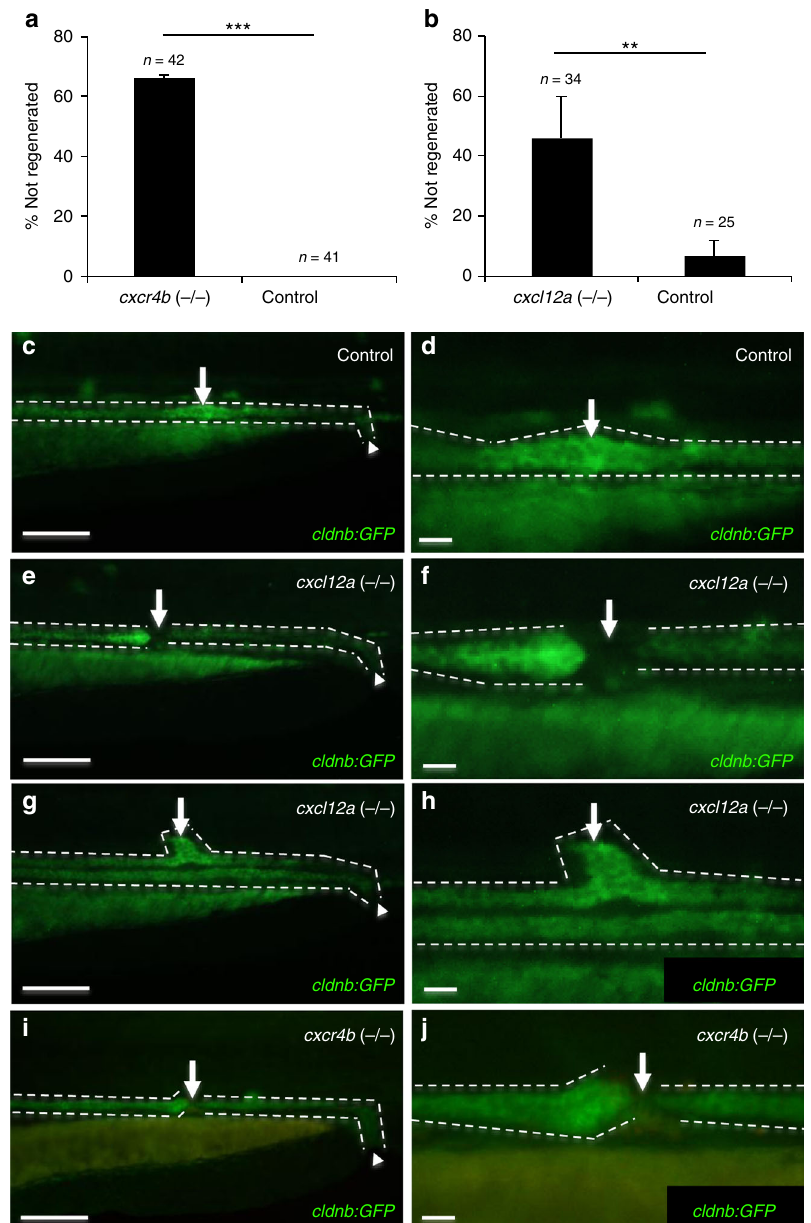
Fig. 4 Defective repair in cxcl12a ( − / − ) and cxcr4b ( − / − ) zebra fi sh embryos. a While control zebra fi sh embryos repair a lased-induced injury, more than 60% of cxcr4b -de fi cient zebra fi sh embryos (means ± SEM; *** p < 0.001; t -test) and b more than 40% of cxcl12a -de fi cient zebra fi sh embryos did not repair